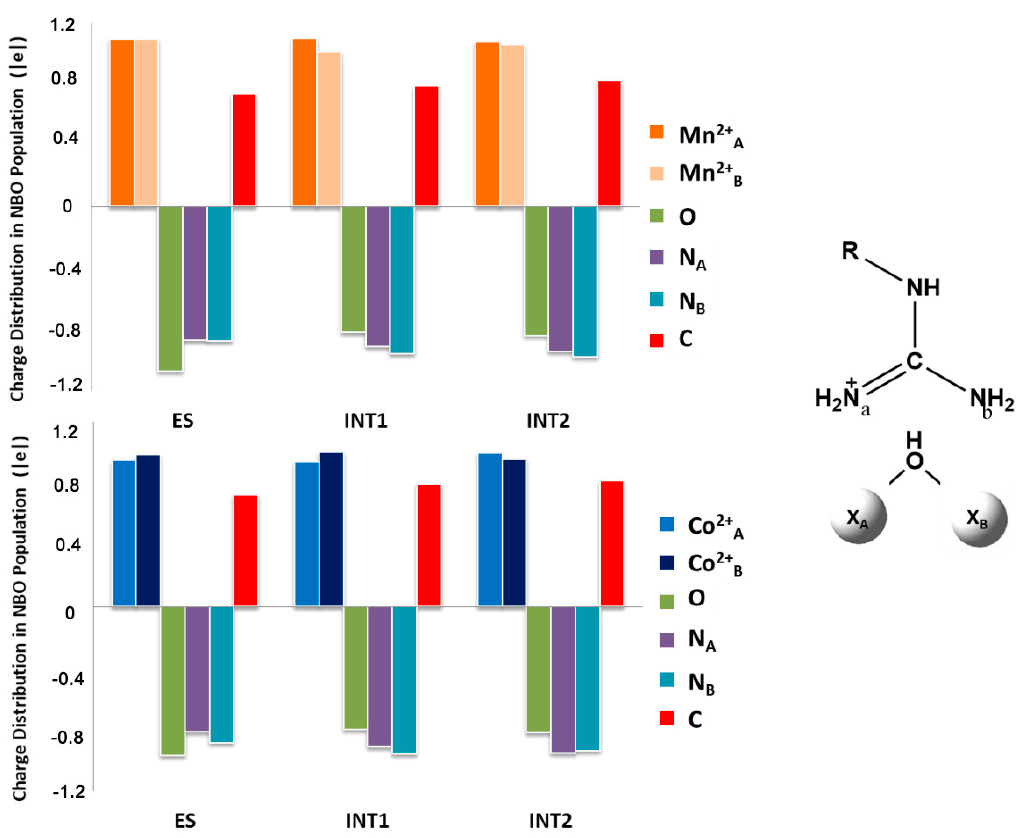
Figure 9. Charge distributions in significant stationary points on the energy profiles of Co 2+ − Co 2+ and Mn 2+ -Mn 2+ arginase enzymes.